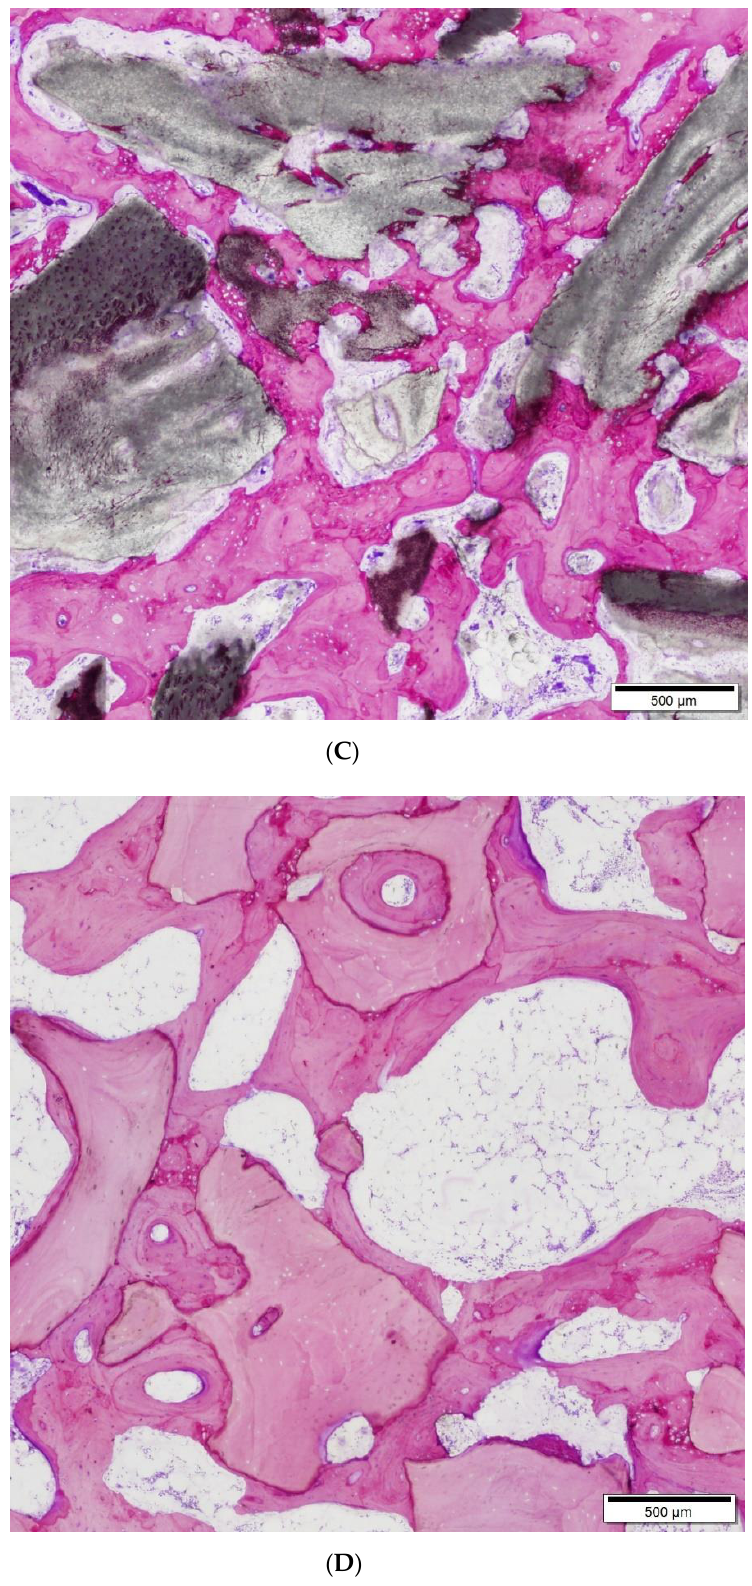
Figure 2. Optical images of shark tooth-derived bone graft ( A , C ) and Bio-Oss ® ( B , D ). Original magnification 4× ( A , B ), and higher magnification ( C , D ).